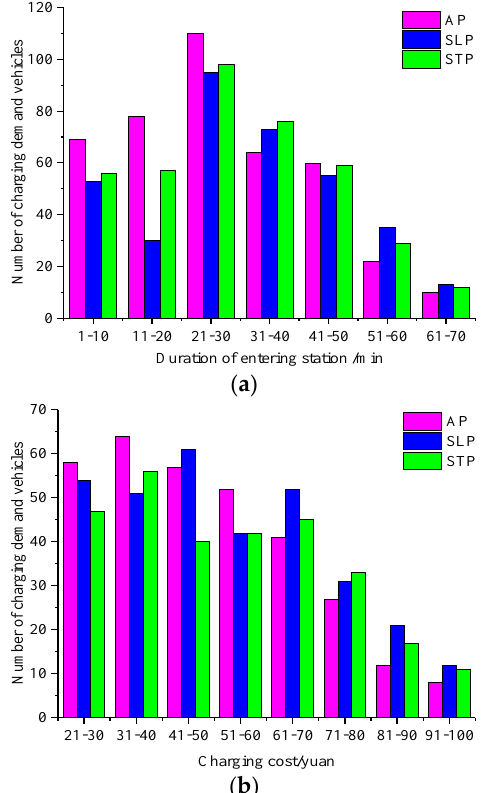
Figure 16. Duration of entering station and charging cost for AP, SLP and STP path strategies. ( a ) Duration of entering station for AP, SLP and STP path strategies. ( b ) Charging cost for AP, SLP and STP path strategies.